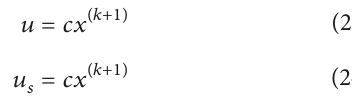
Figure 3: Flowchart of LCNSGA-III for